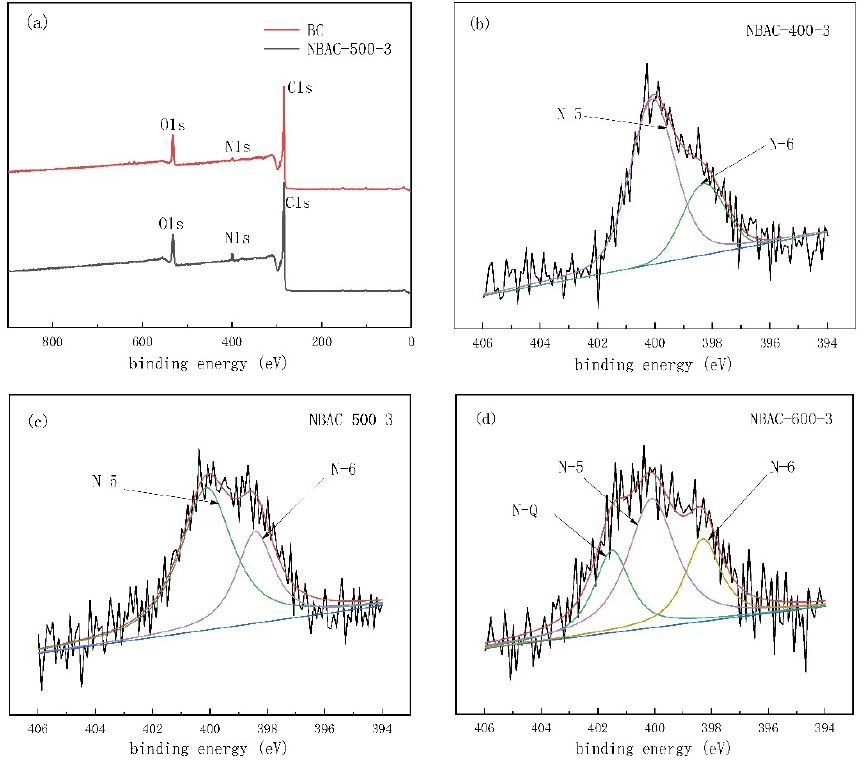
Figure 3. XPS spectra of NBAC-500-3 ( a ) and fitting curves of NBAC-400-3 ( b ), NBAC-500-3 ( c ) and NBAC-600-3 ( d ) synthesized from dry chemical activation.